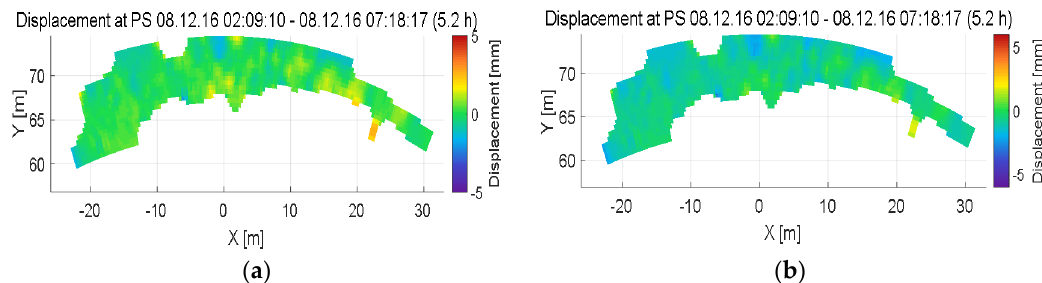
Figure 15. Deformation results before and after atmospheric correct. (a) indicates before atmospheric correction, and (b) indicates after atmospheric correction. correction, and ( b ) indicates after atmospheric